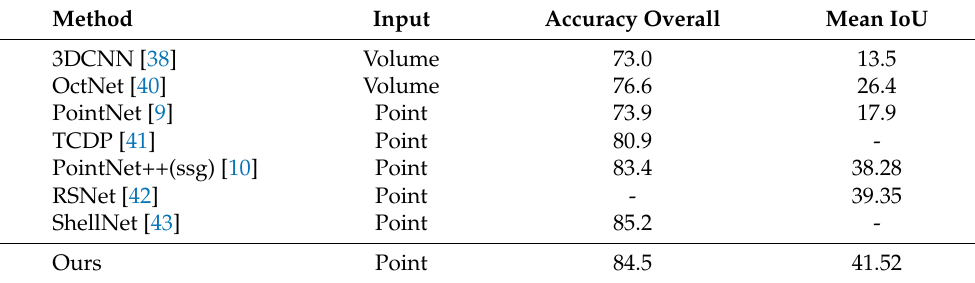
Table 2. Comparison of Segmentation results on ScanNet dataset.